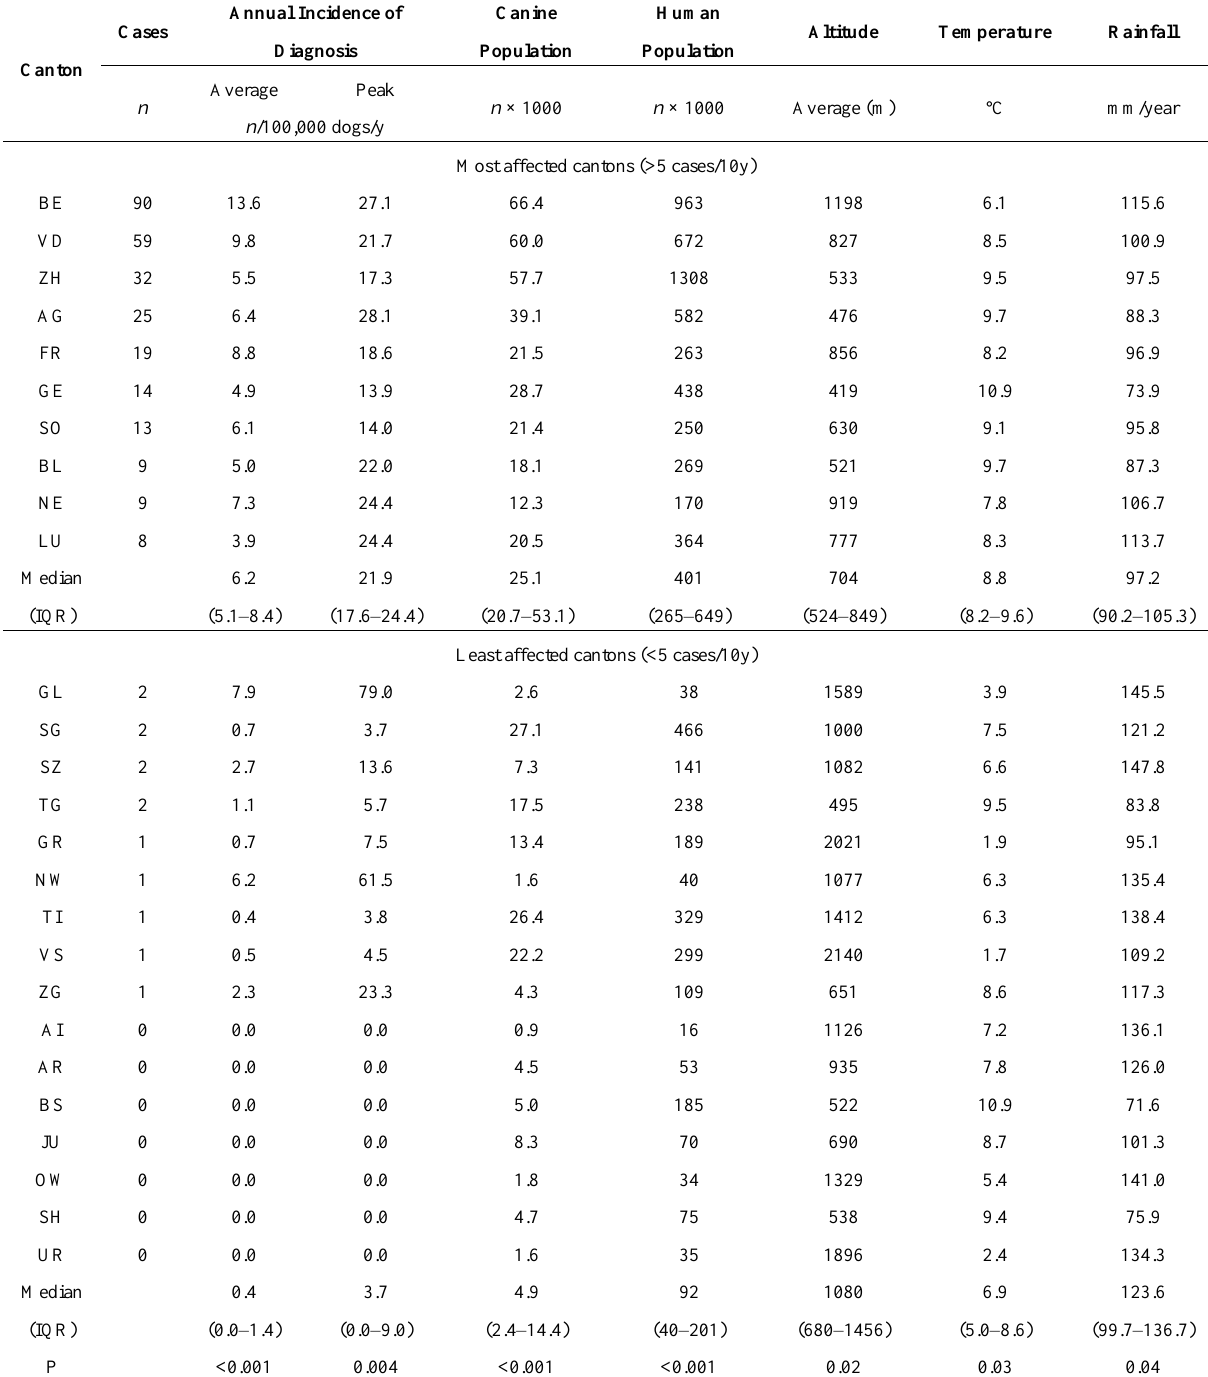
Table 2. Cantonal distribution of 298 cases of canine leptospirosis and relationship to geoclimatic